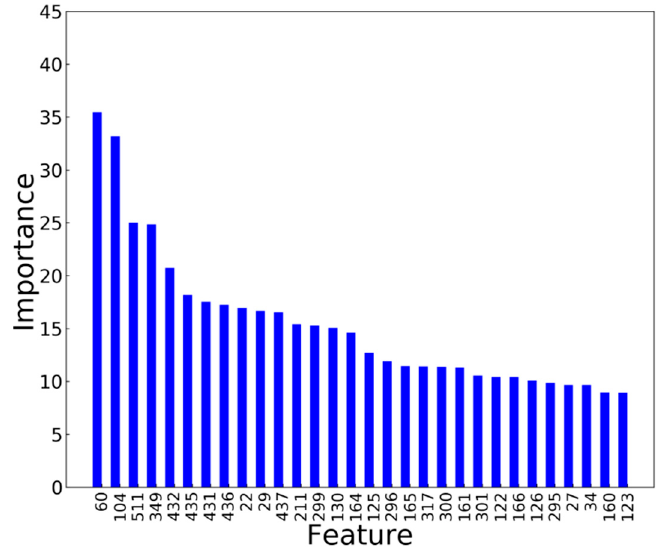
Figure 16. Importance of each feature.